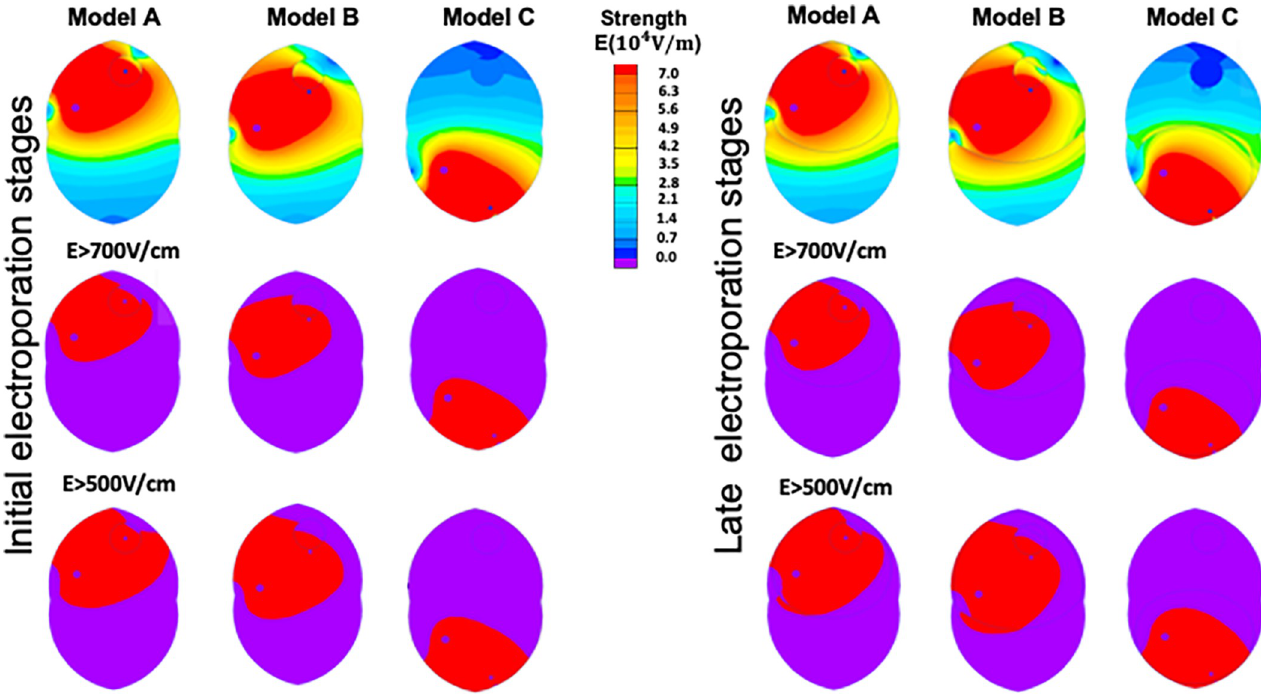
Fig 3. Electric field distribution in the brain with melanoma metastasis during e-biopsy. Simulations results for the three scenarios are shown: e-biopsy needle in the center of the tumor (Center, Model A), e-biopsy needle at the distance of 0.5mm from the visible tumor margin (Margin, Model B), and e-biopsy needle at the distance of 10mm (Healthy brain, Model C). The left set of models shows the electric field distribution at the early stages of electroporation: healthy brain conductivity 0.258 S m -1 , melanoma conductivity 0.43 S m -1 [52]. Right panel shows the electric field distribution at the late stages of electroporation when the tissue conductivity increases [53]: brain conductivity 0.882 S m -1 , melanoma conductivity 1.47 S m -1 .